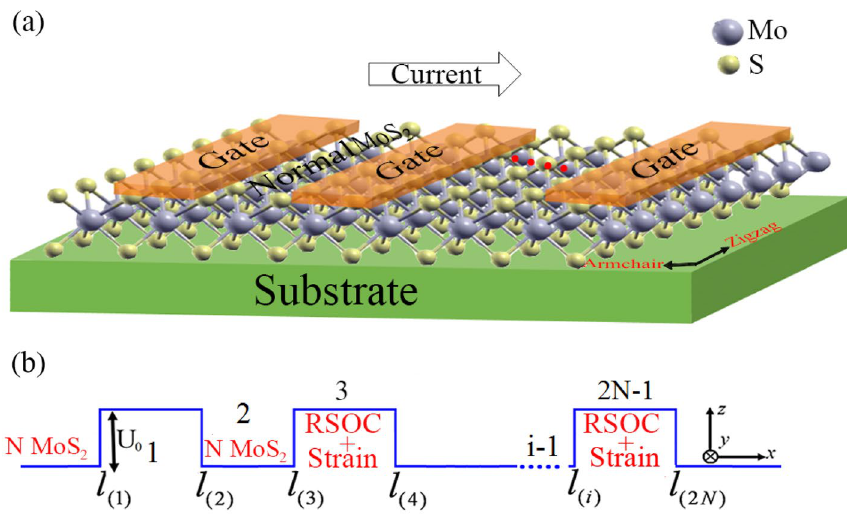
Figure 1. ( a ) Schematic representation of a monolayer MoS 2 superlattic under strain and RSOC. ( b ) Energy potential profile of MoS 2 superlattic with N electrostatic potential